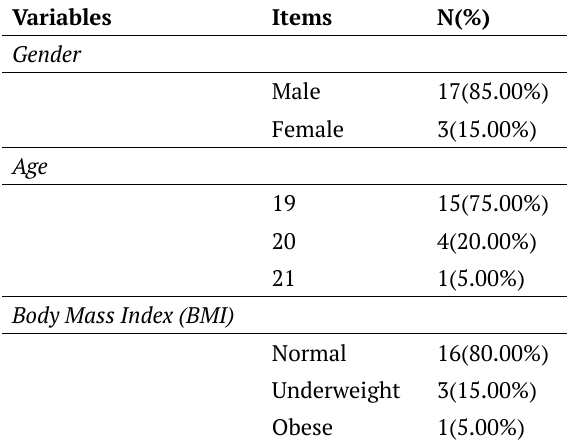
Table 1. Personal information of the participants